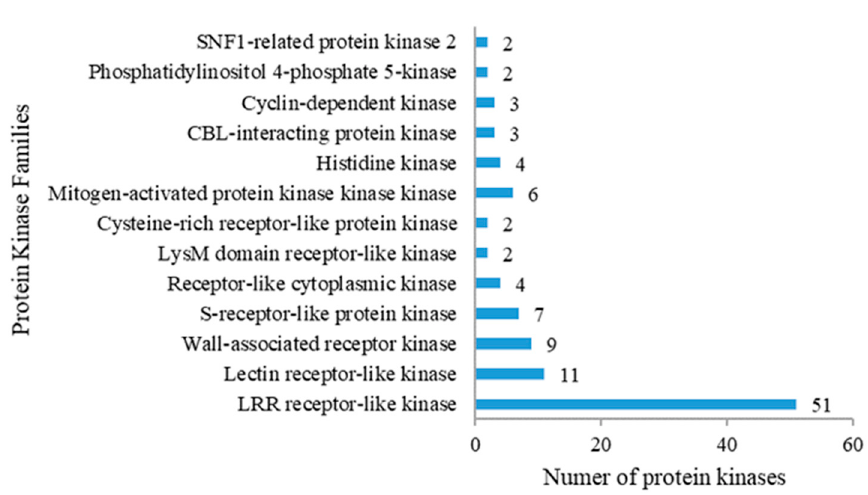
Figure 5. Protein kinases differentially expressed under drought stress in P3-198.